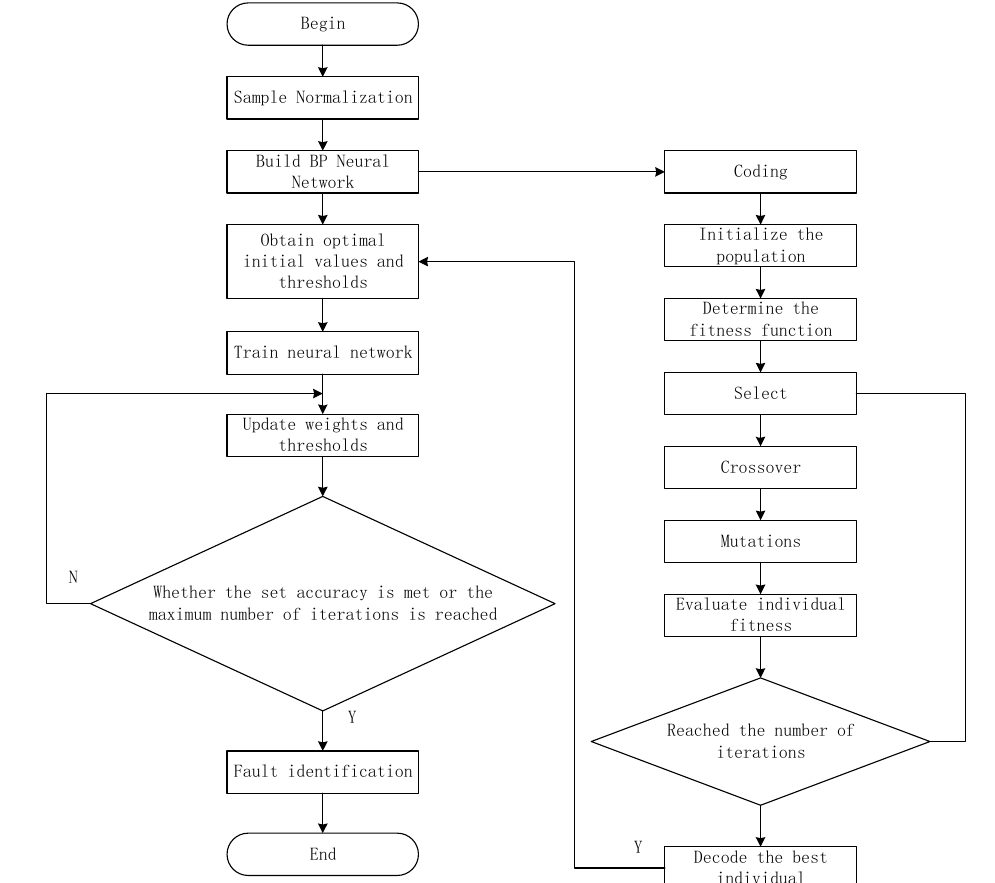
Figure 4. GA-BP algorithm fault identification block diagram.